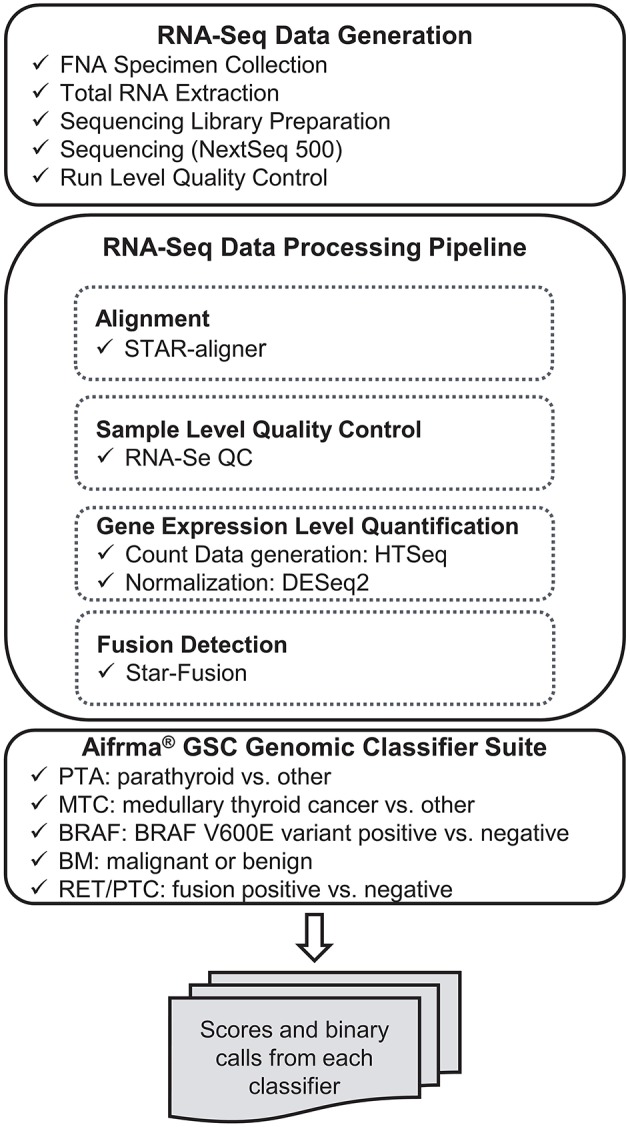
Analytical verification study data generation workflow.